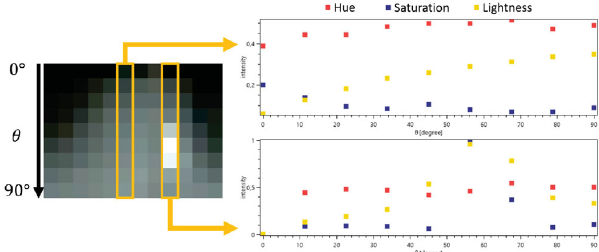
Lightness curves of a pixel for different angles of rotation in HSL color space. Note how hue (red) and saturation (blue) remain almost constant. The deviation in the graph is due to the specular highlight at the respective